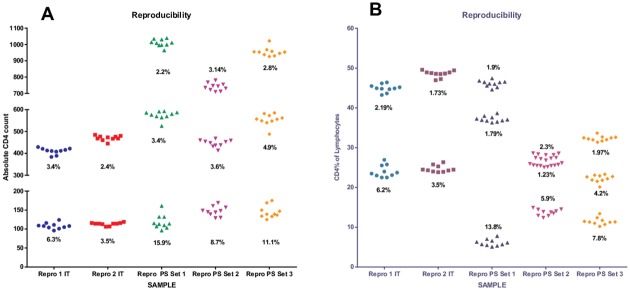
Reproducibility of FACSPresto™.Reproducibility of the FACSPresto™ system was assessed for (A) absolute CD4 counts and (B) CD4% of lymphocytes. Two sets of ten samples were analysed for Beckman Coulter Immunotrol (IT) normal and low (Repro 1 and 2 IT) and for nine patient samples (PS) with low, medium and high CD4 counts (3 per group), indicated as Repro PS Set 1–3. %CV results are indicated for each data set.